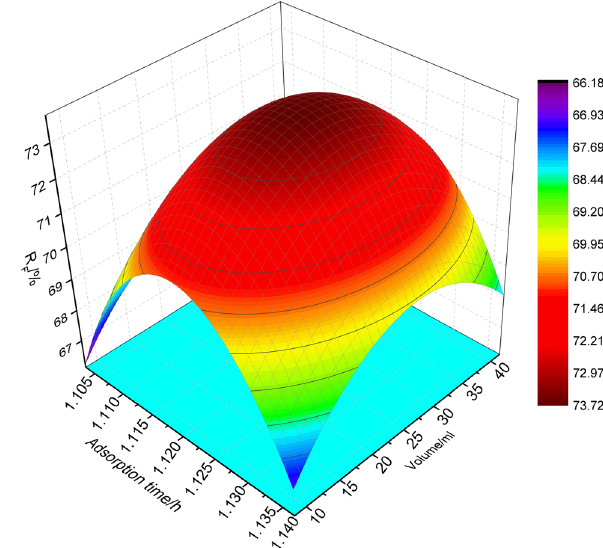
Figure 9: InteractionofadsorptiontimeandpHontheresponsesurface.